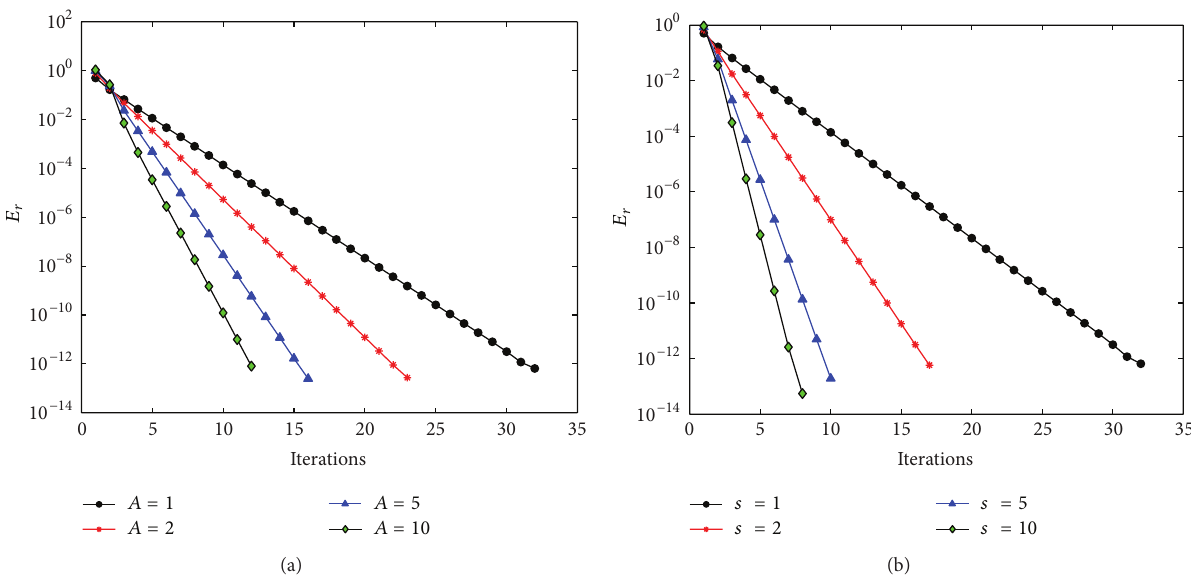
Figure 1: Effect of varying the parameters 𝐴 and 𝑠 on the error 𝐸 𝑟 from the SRM.